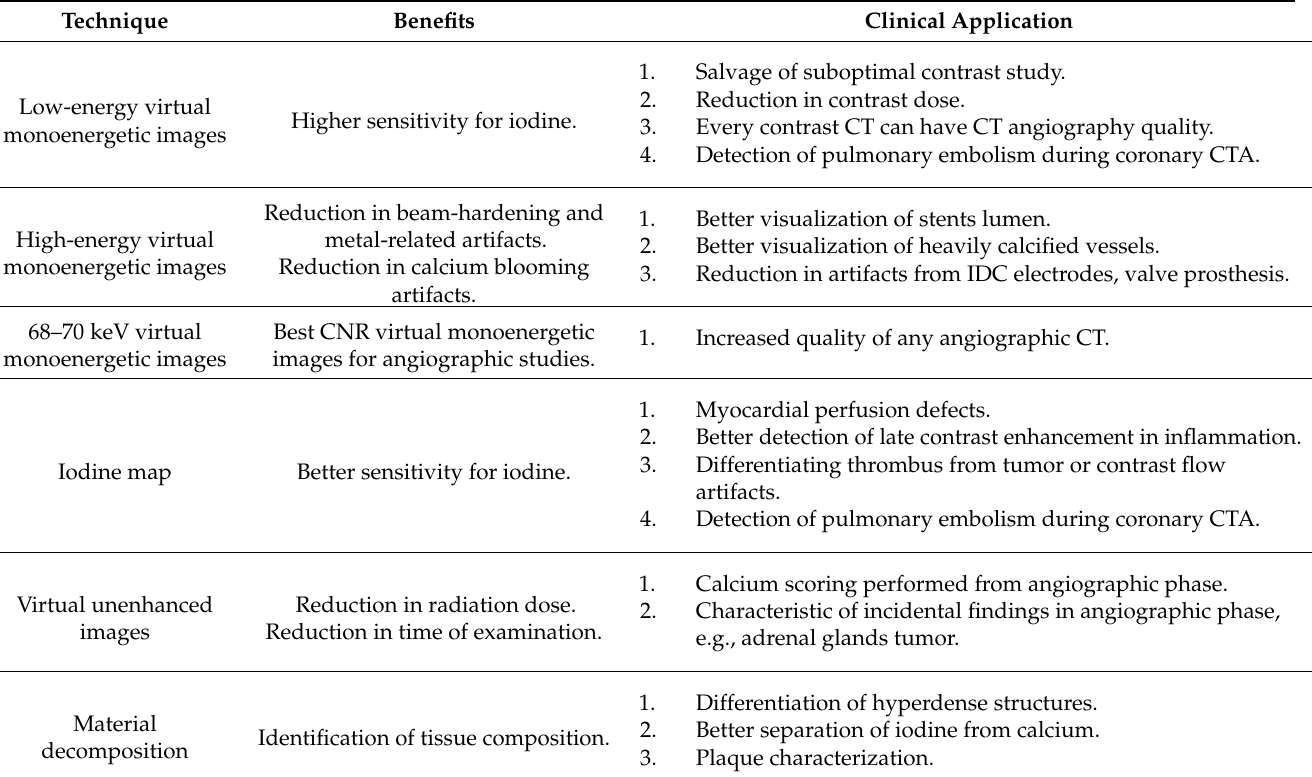
Table 3. Summary of DECT advantages and its current uses in clinical